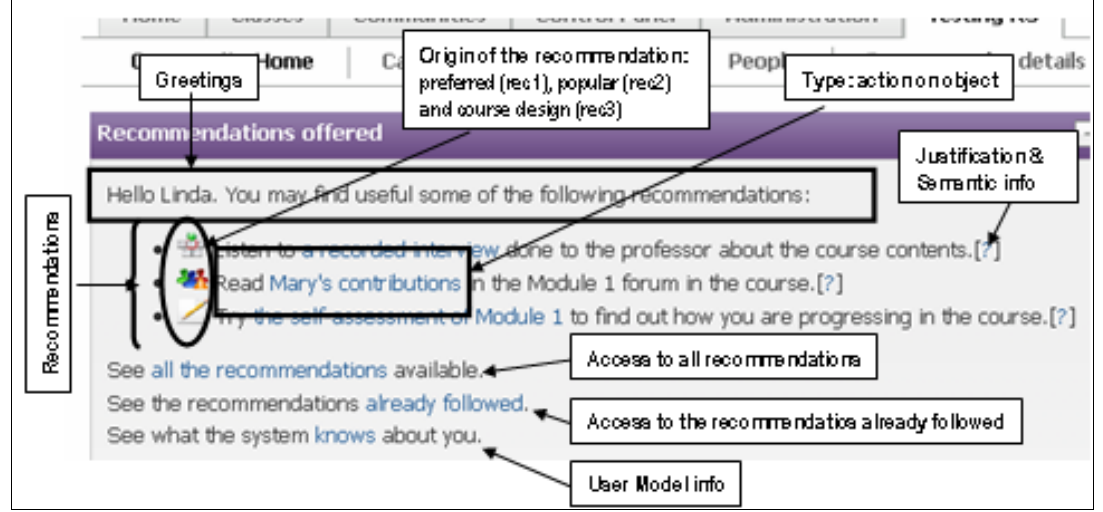
Figure 3. Recommendation list shown in the LMS GUI.